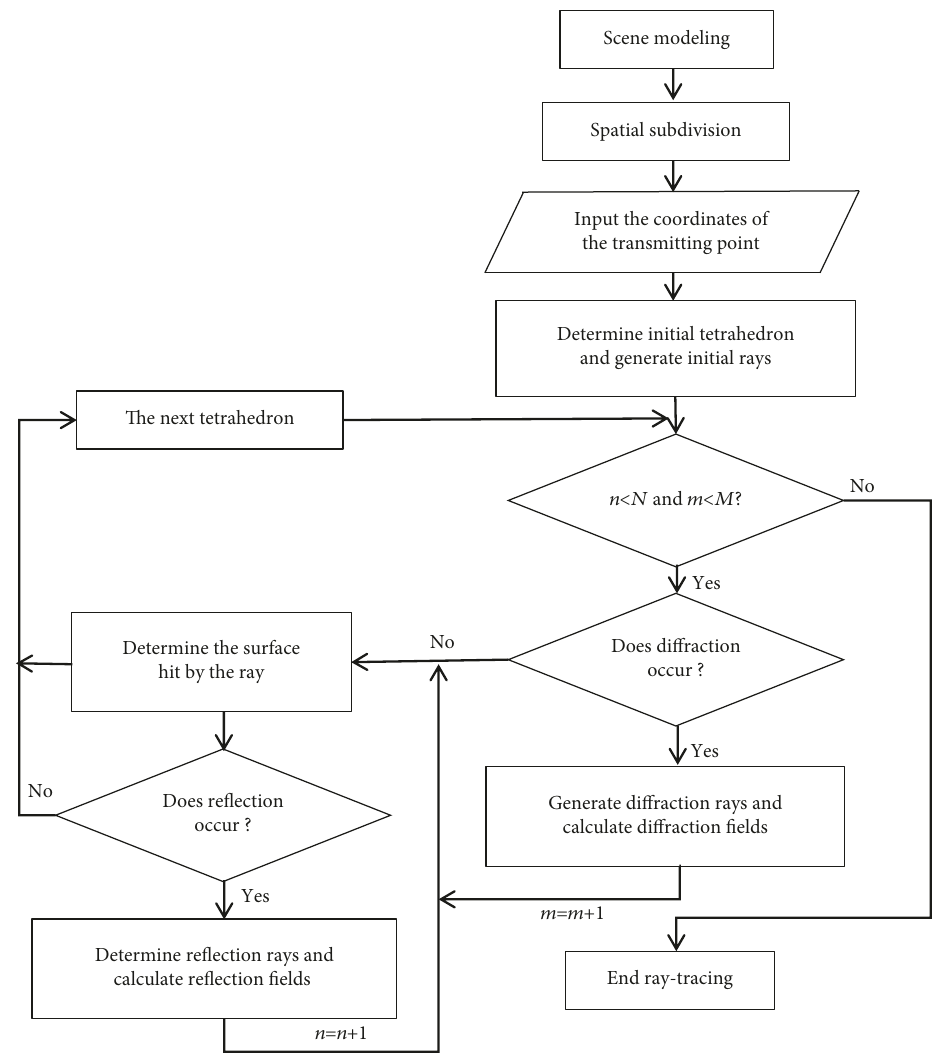
Figure 3: Flow chart of the 3D fast ray-tracing